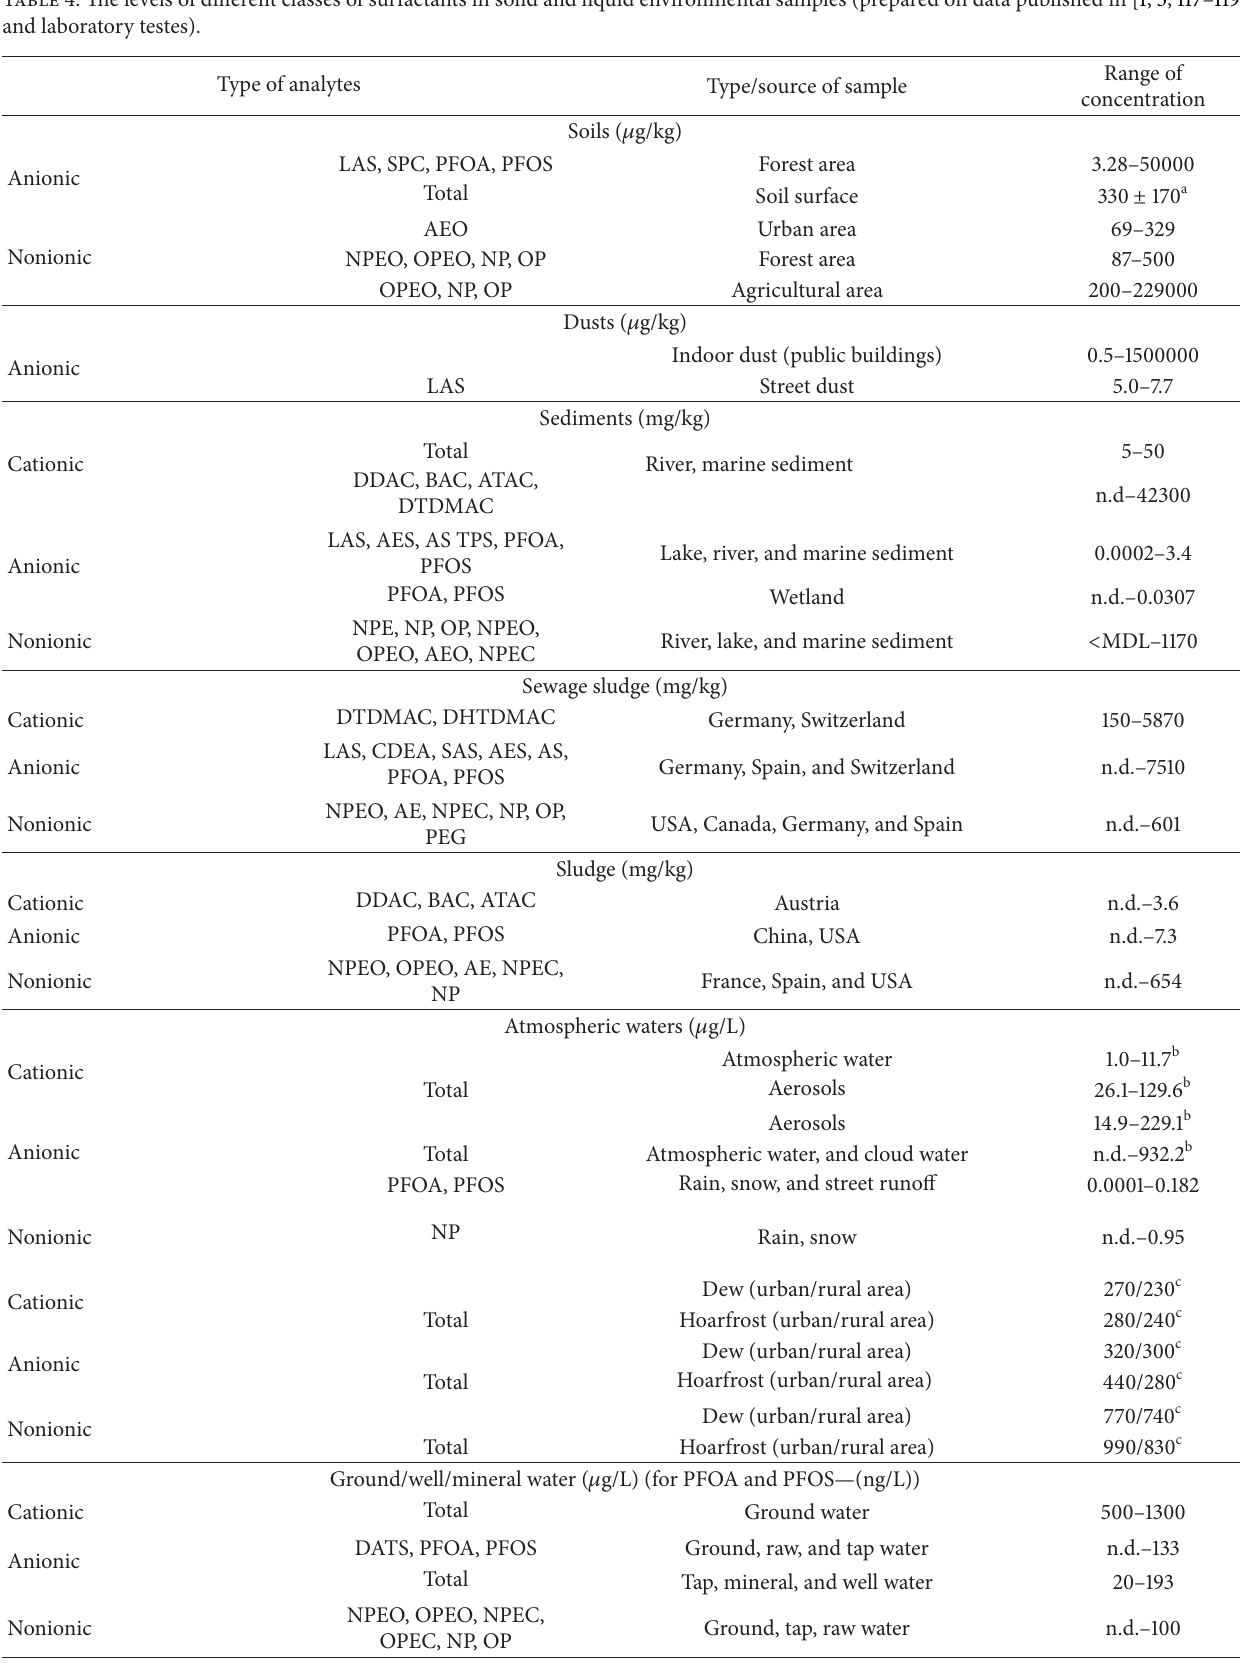
Table 4: The levels of different classes of surfactants in solid and liquid environmental samples (prepared on data published in [1, 3, 117–119] and laboratory